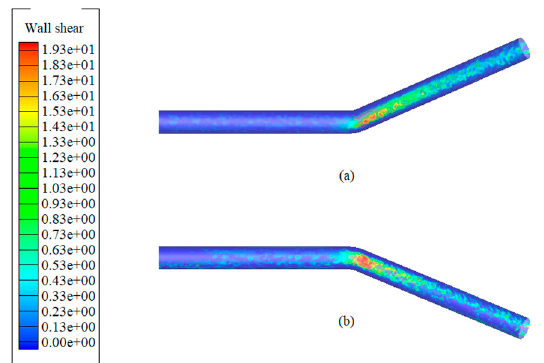
Figure 10. Contours of the wall shear stress for both upward and downward pipes carrying 30% water–70% gas at a gas superficial velocity of 1 m/s ( a ) upward pipe, and ( b ) downward pipe.